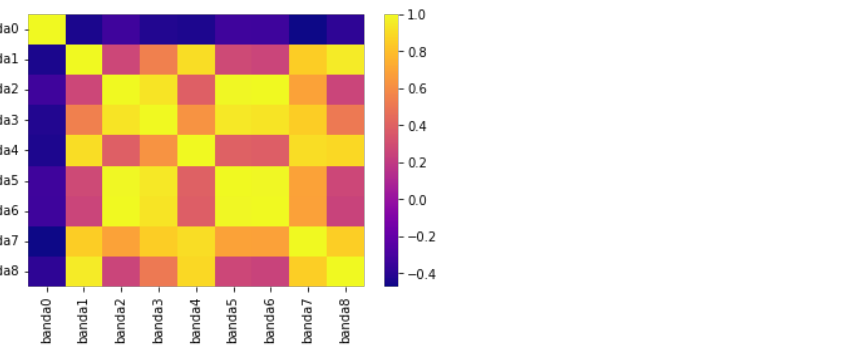
Figure 19. Application of Pearson’s correlation on the different columns of the electrophoresis sample.